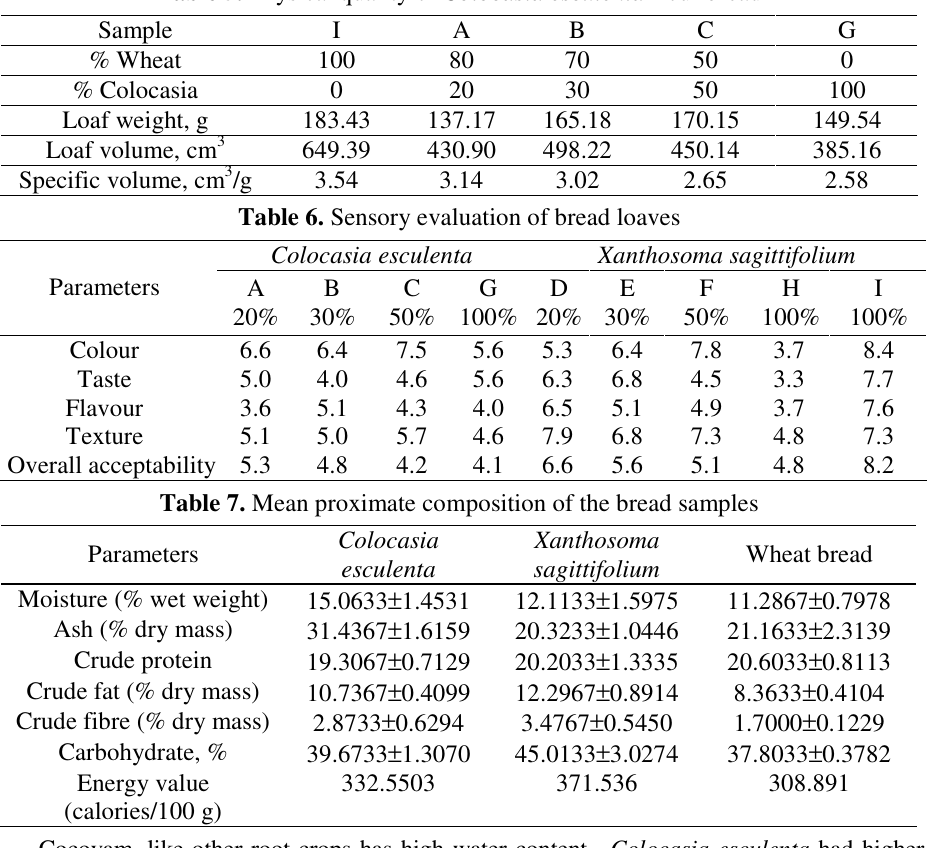
Table 5. Physical quality of Colocasia esculenta flour bread